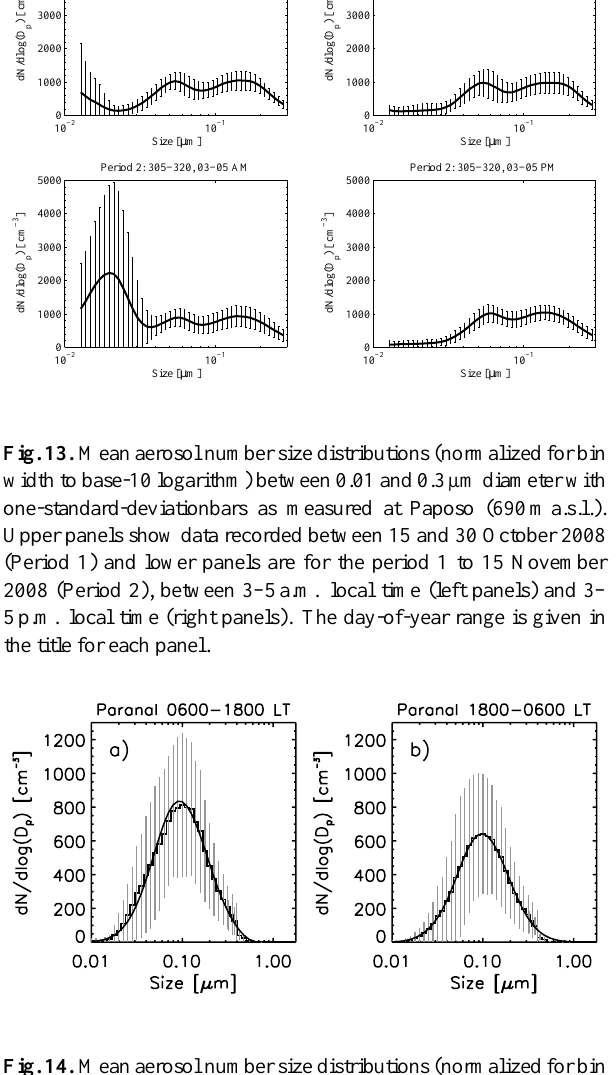
Fig. 14. Mean aerosol number size distributions (normalized for bin width to base-10 logarithm) between 0.01 and 1.1µm diameter with one-standard-deviation bars as measured at Paranal (2635ma.s.l.) between (a) 06:00 and 18:00LT (left panel); and (b) 18:00 and 06:00 LT (right